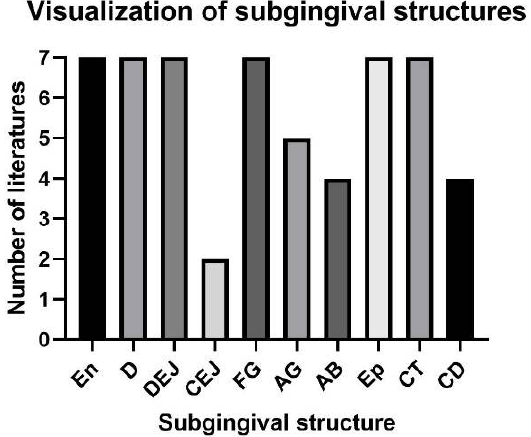
Figure 1. Comparison and distribution of visible subgingival structures reported from the included literatures. The score in the y -axis indicates the number of literatures that reported the visibility of the subgingival structures.